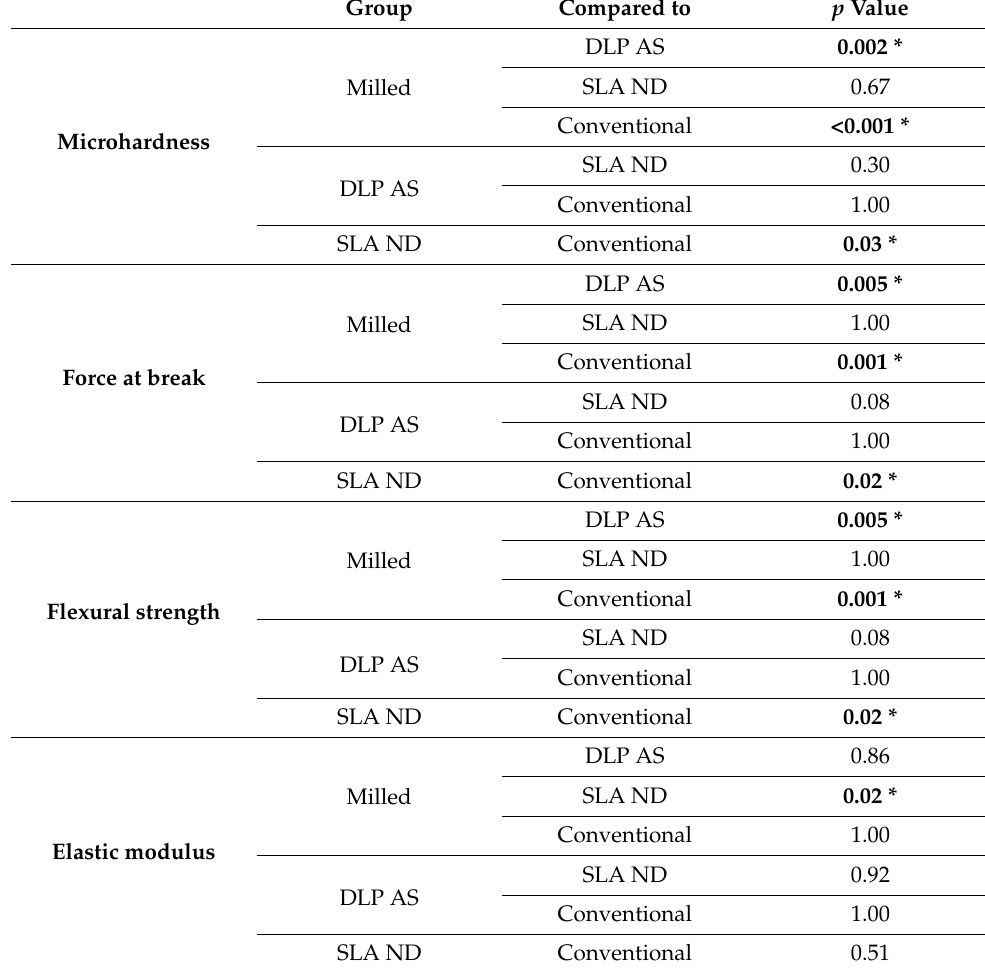
Table 3. Post hoc comparisons between different studied materials and